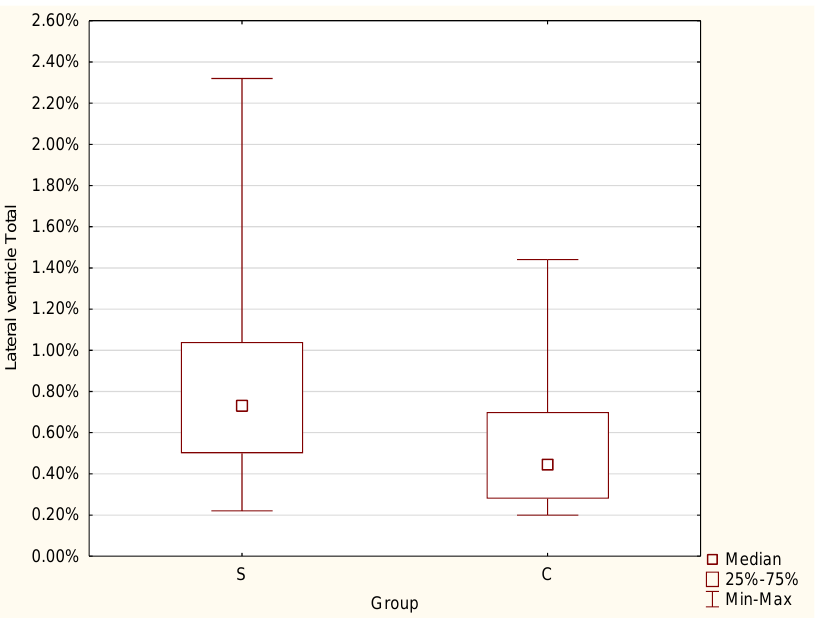
Figure 7. Differences in lateral ventricles volume between the C and S groups.